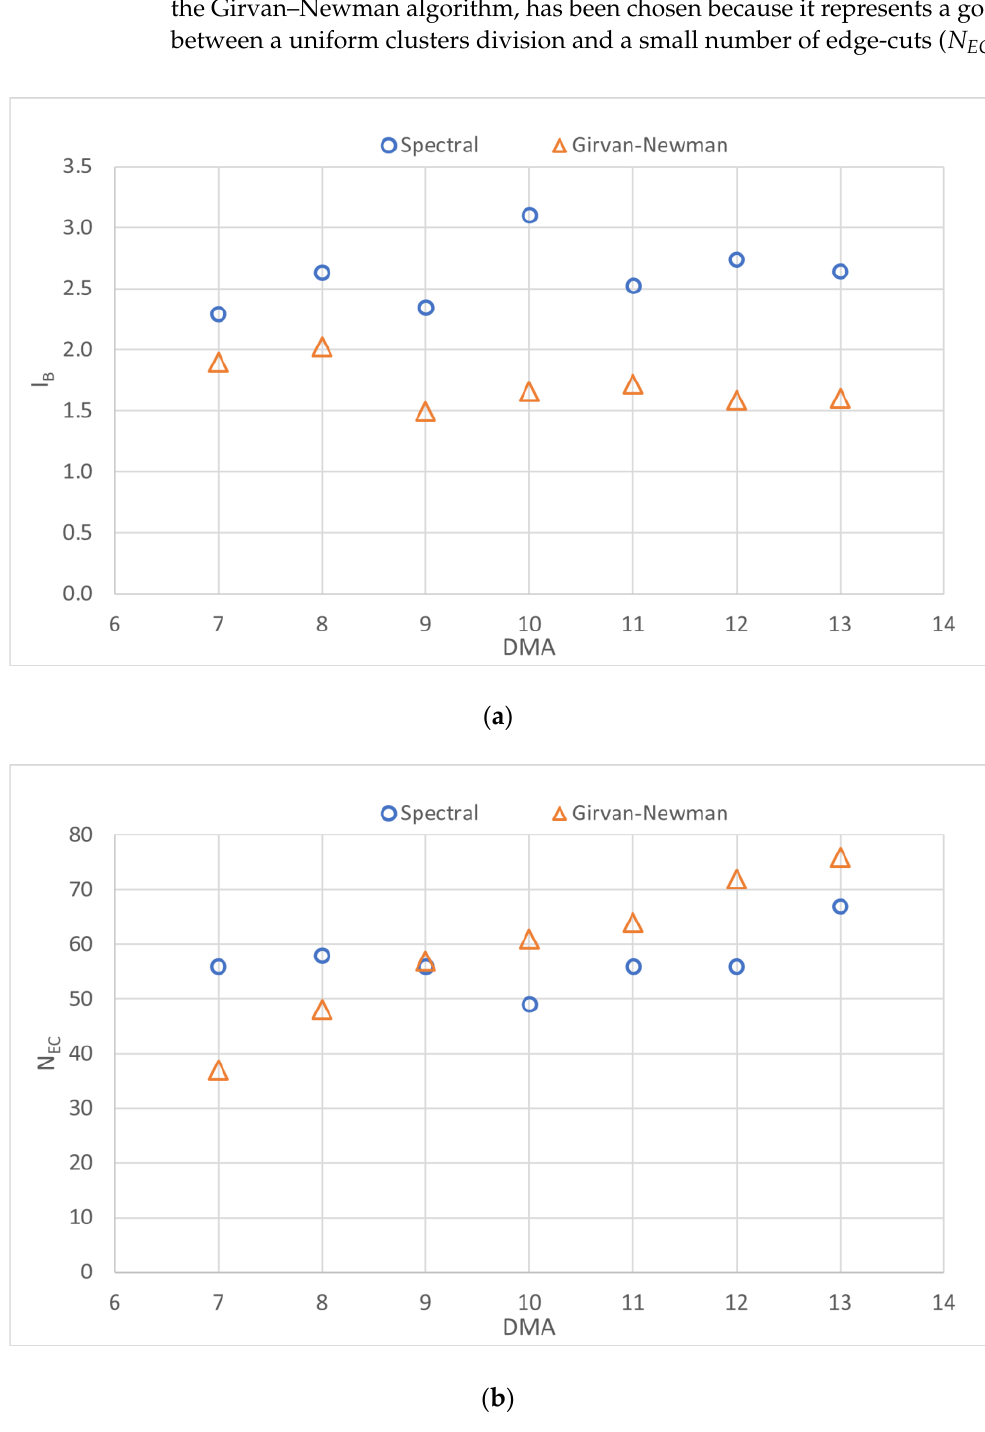
Table 2. Number of edge-cuts, clustering, and hydraulic indices for spectral clustering and Girvan– Newman algorithm.